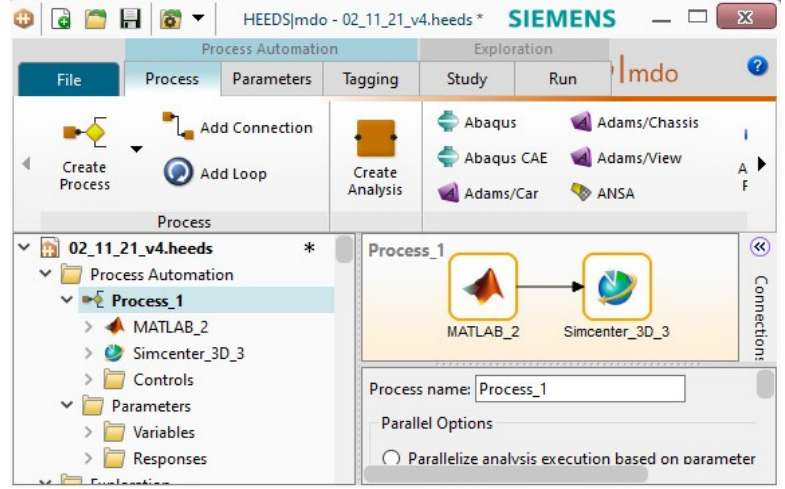
Figure 2. HEEDS graphical user interface.